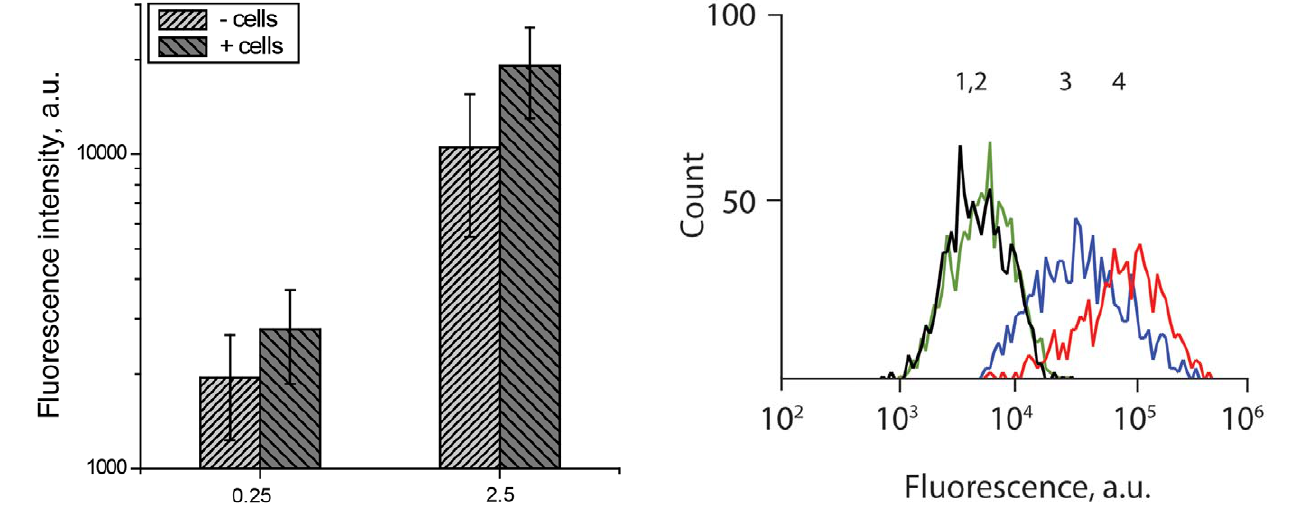
Figure 5. Utility of SMEPT in conversion of fluorogenic prodrug and cargo uptake is verified through quantification of fluorescence of hepatic cells cultured on the m S PVA hydrogels. Administration of FdG in the absence of enzyme led to a negligible change in the fluorescence of cultured cells (traces 1 : cells only, trace 2 : + FdG). SMEPT conditions (trace 3 : b -Glu immobilized within m S hydrogels, + FdG) afforded comparable level of fluorescence of the cultured cells as solution based administration (trace 4 : b -Glu and FdG are added to media above cultured cells), as quantified by flow cytometry analysis of harvested cells. In all cases, [FdG]=2,5 m g/mL.